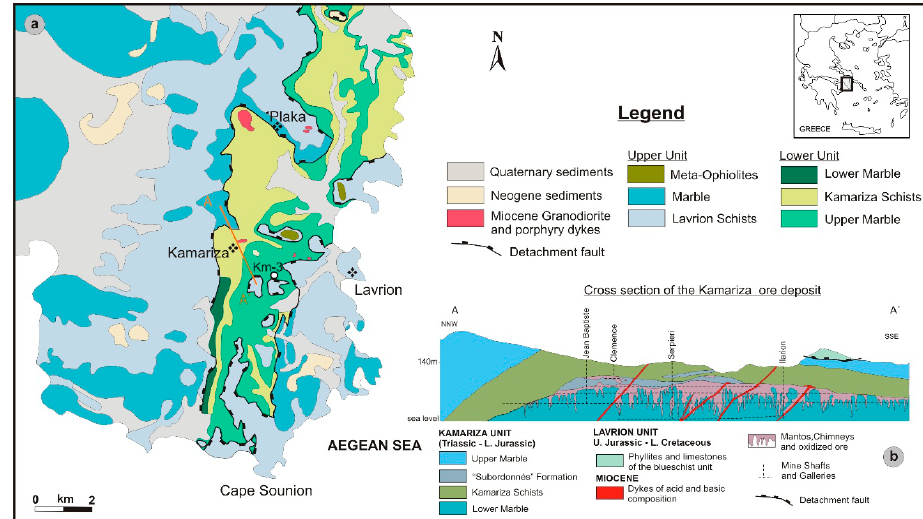
Figure 1. ( a ) Simplified geological map of the Lavrion ore district; ( b ) cross-section A–A ′ of the Kamariza deposit (modified after Marinos and Petraschek [1] and Scheffer et al. [22]). Minerals 2018 , 8 , x FOR PEER REVIEW Table 1. Major (in wt.%) and trace element content (in ppm) of microgranite porphyry from the Serpieri mine.